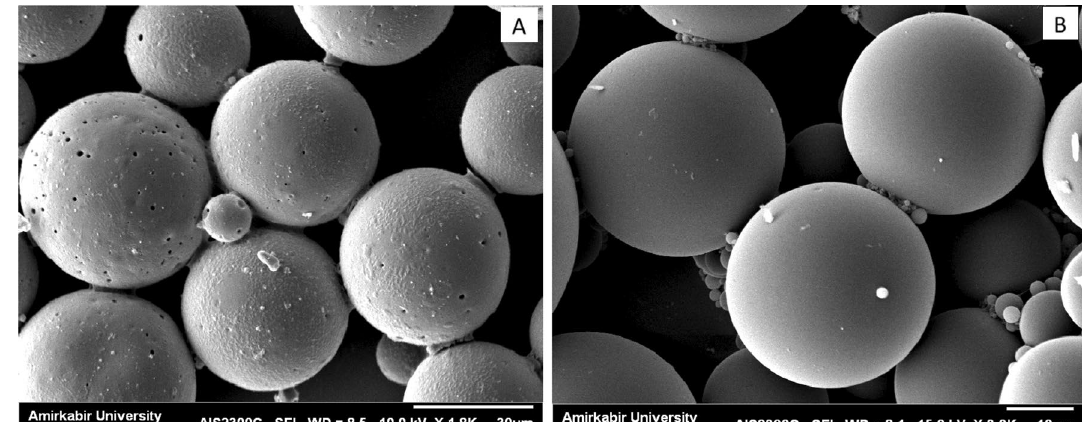
Figure 1. Morphology studies of conventional PLGA microparticles ( A ) and GA-PLGA-CH-AL hydrogel microparticles (GMIX22) ( B ) by SEM.